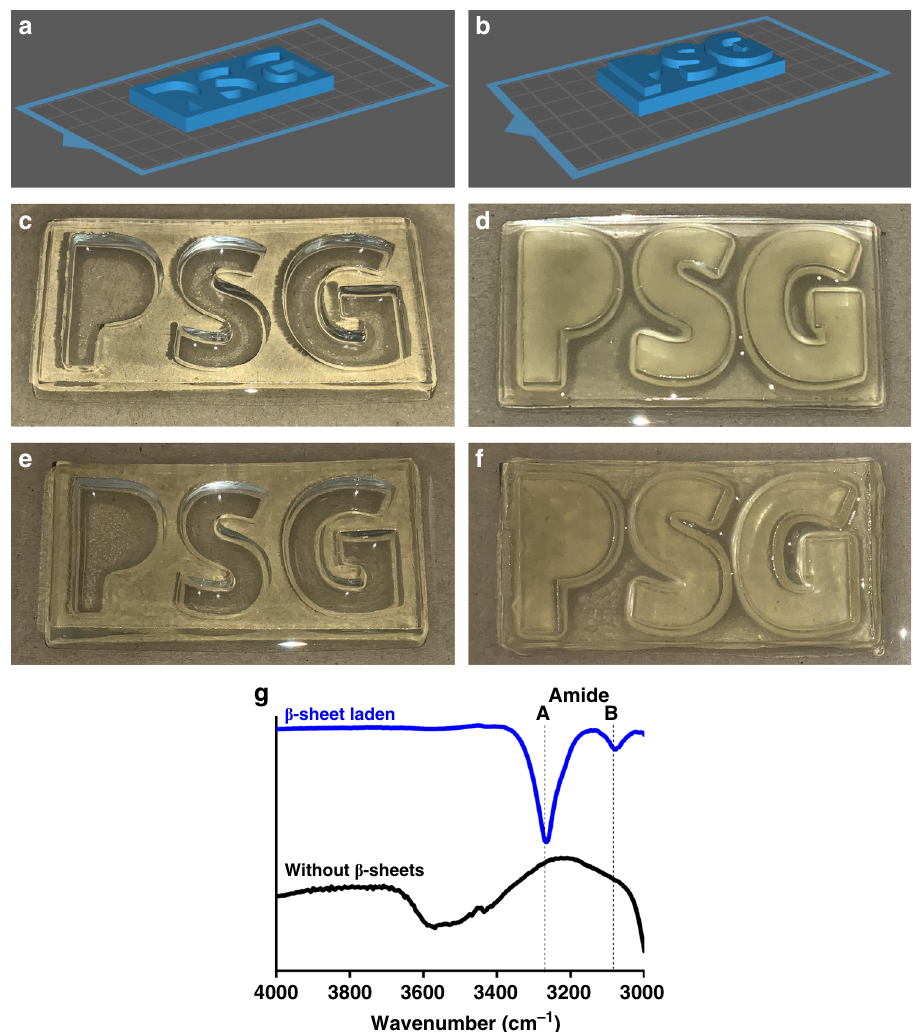
Fig. 9 3D-printed networks with similar chemical composition to previous hydrogels. a , c , e Are all based off a model printed with letters imprinted into a rectangular plate while b , d , f are all based off a model printed with letters protruding from a rectangular plate. a , b Are the original 3D models that were printed, c , d are the 3D-printed networks immediately after printing and e , f are the 3D-printed networks after NCA ROP had been performed on them. g ATR-FTIR of a 3D-printed network before and after NCA printing between 3000 and 4000 cm − 1